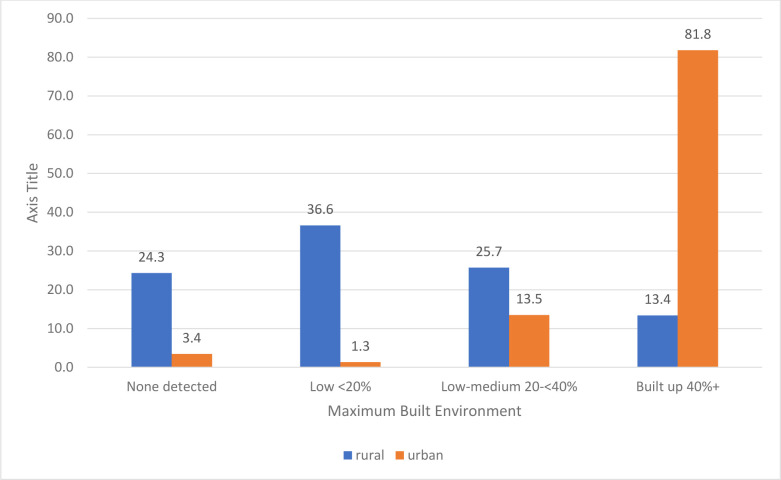
Distribution of the maximum built environment across urban and rural locations.